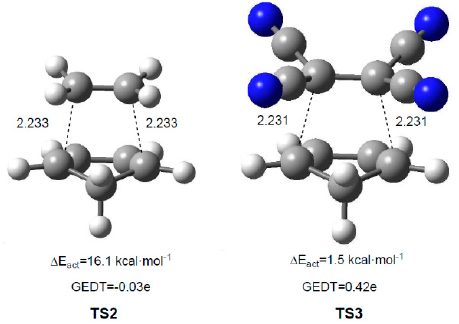
Figure 4. MPWB1K/6-31G(d) geometries and lengths of the forming bonds, in Angstroms, activation energies, in kcal·mol − 1 , and GEDT values, in e, of the TSs involved in the non-polar DA reaction between Cp 6 and ethylene 2 , TS2 , and in the polar DA reaction between Cp 6 and TCE 9 , TS3 . Similar to the non-polar DA reaction between butadiene 1 and ethylene 2 , the reaction between Cp 6 and ethylene 2 presents a high activation energy, 16.1 kcal·mol − 1 . Note that ethylene 2 has been classified as a marginal electrophile and as a marginal nucleophile, not being able to participate in polar processes [69]. On the other hand, TCE 9 is one of the most electrophilic ethylenes [69]. This fact, together with the high nucleophilic character of Cp 6 , causes this polar DA reaction not to have an appreciable barrier, 1.5 kcal·mol − 1 . Consequently, a decrease of ca. 15 kcal·mol − 1 is observed in this polar DA reaction. Non-polar TS2 does not present any appreciable GEDT value, − 0.03 e, while polar TS3 presents a high GEDT value, 0.42 e. A comparison of the geometrical parameters of these TSs indicates that the lengths of the C–C forming single bonds at both TSs are very similar, 2.233 Å ( TS2 ) and 2.231 Å ( TS3 ). Consequently, it is expected that the distribution of the total electron density in both TSs will be similar, and therefore, they will have a similar bonding pattern. Hence, where is the electronic difference between both TSs? ELF topological analysis of the electron density of the TS associated with the non-polar DA reaction between Cp 6 and ethylene 2 ,